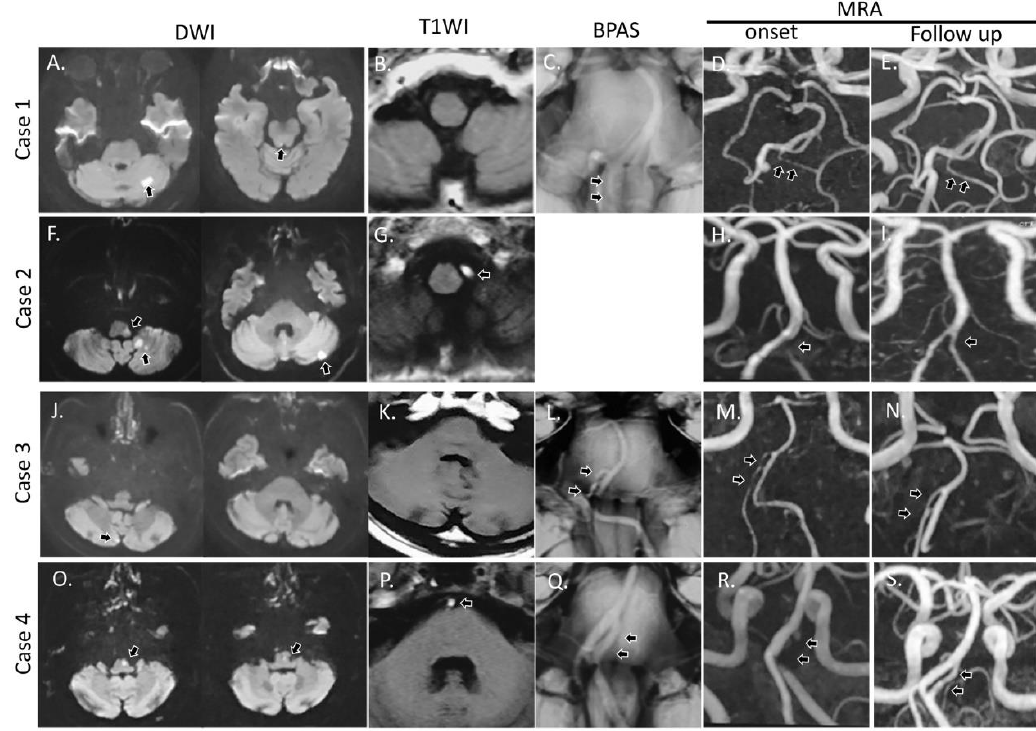
Figure 1. Magnetic resonance imaging (MRI) of our cases on diffusion weighted image (DWI; A , F , J , O ), T1WI (for intramural hematoma; B , G , K , P ), basi-parallel anatomic scanning magnetic resonance imaging (BPAS; C , L , Q ) and magnetic resonance angiography (MRA, onset; D , H , M , R , follow-up; E , I , N , S ). Case 1; Acute infarction at the left cerebellum and dorsal pons ( A ; arrow), but no intramural hematoma. The left vertebral artery was observed on BPAS ( C ; arrow), but not on MRA ( D ; arrow). On follow-up MRA, the left vertebral artery was observed ( E ; arrow). Case 2; Acute infarction was observed in the lateral medulla and cerebellum ( F ; arrow). Intramural hematoma was noted at the left vertebral artery ( G ; arrow). On initial MRA, string sign was seen in the left vertebral artery ( H ; arrow). On follow-up MRA, the left vertebral artery was visualized ( I ; arrow). Case 3; Dotted acute infarction was noted in the right cerebellum ( J ; arrow), but there was no intramural hematoma ( K ). On BPAS and MRA, the right fenestrated artery and vertebral artery were string-shaped ( L , M ; arrow). On follow-up MRA, the right fenestrated artery and vertebral artery were visualized more clearly. Case 4; Acute infarction was observed at the dorsal lateral medulla ( O ; arrow) and intramural hematoma was present at the left fenestrated artery ( P ; arrow). On BPAS, the basilar artery was fenestrated ( Q ; arrow), but the left fenestrated artery disappeared on initial MRA ( R ; arrow). On follow-up MRA, the left fenestrated artery reappeared ( S ; arrow).